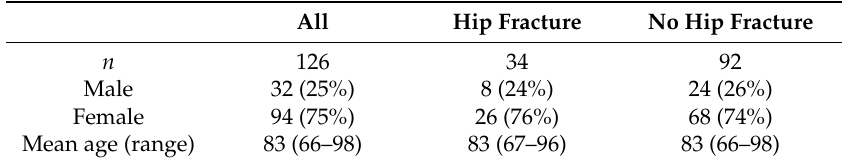
Table 1. Distribution of second-line imaging positive and negative for hip fractures, and associated demographic